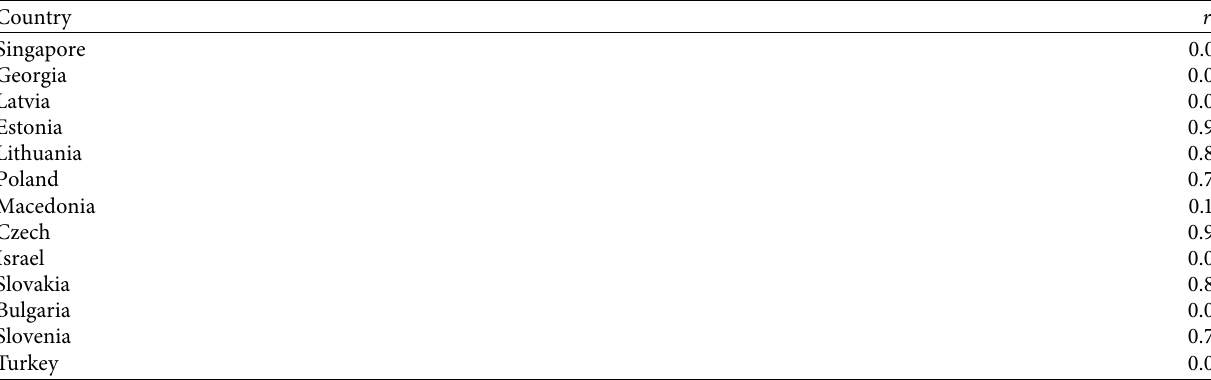
Figure 1: The calculation steps of the FGM (1, 1) model based on PSO algorithm. Table 1: Optimal order value of FGM (1,